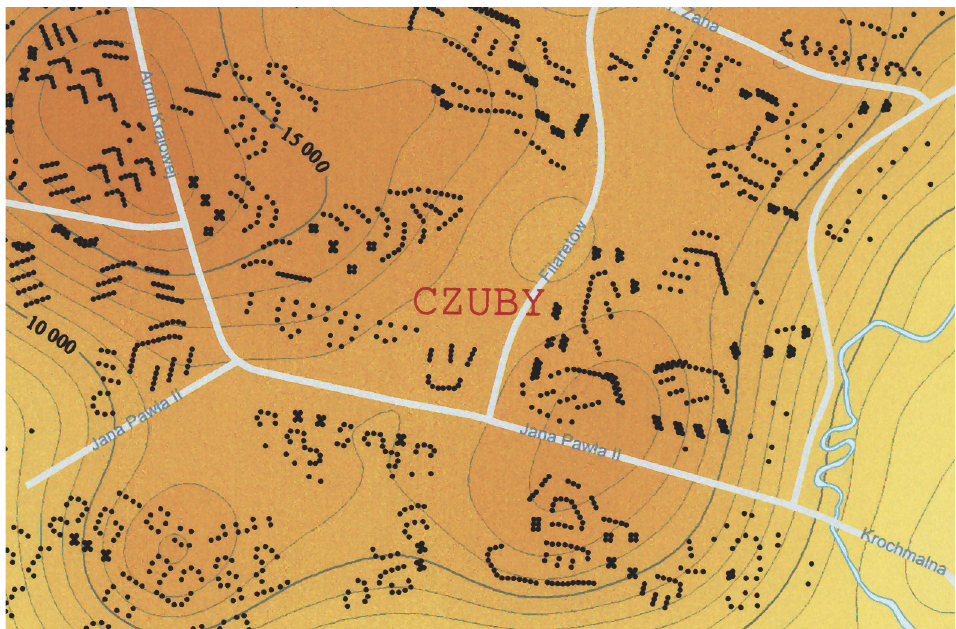
Fig. 5. A part of the isopleth map of population distribution of Lublin in 2014 with main streets which facilitate the analysis of the phenomenon (based on an M.A. thesis of T. Frąś, made at the Department of